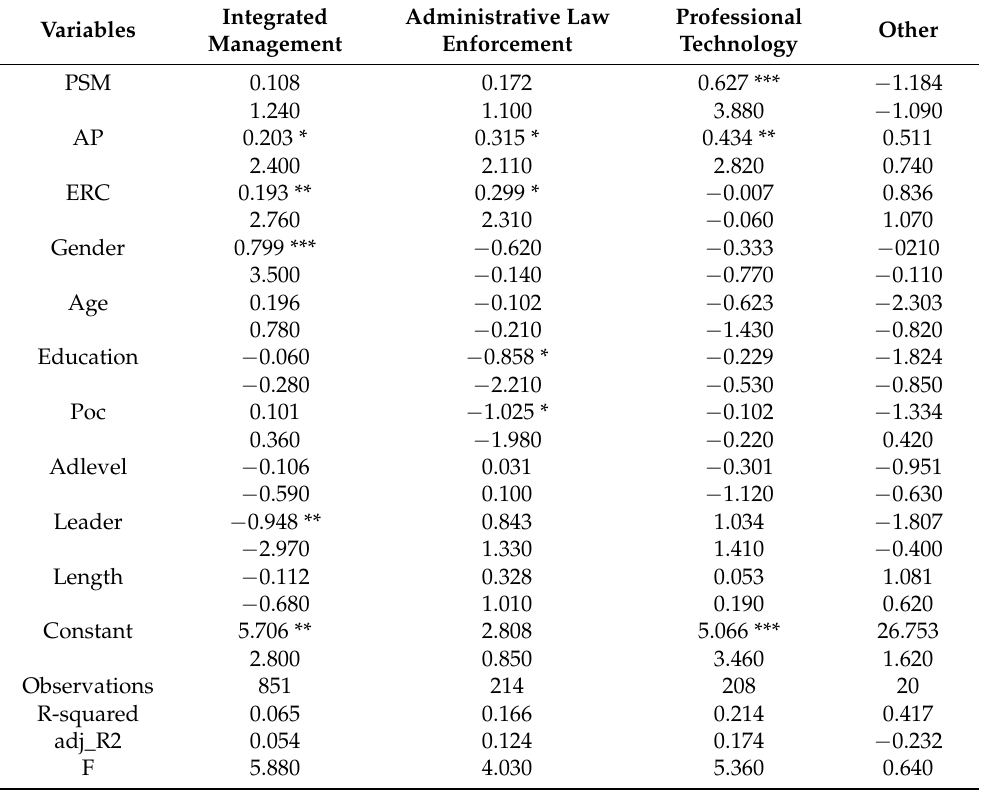
Table 6. Regression on pandemic prevention performance in the different job categories.